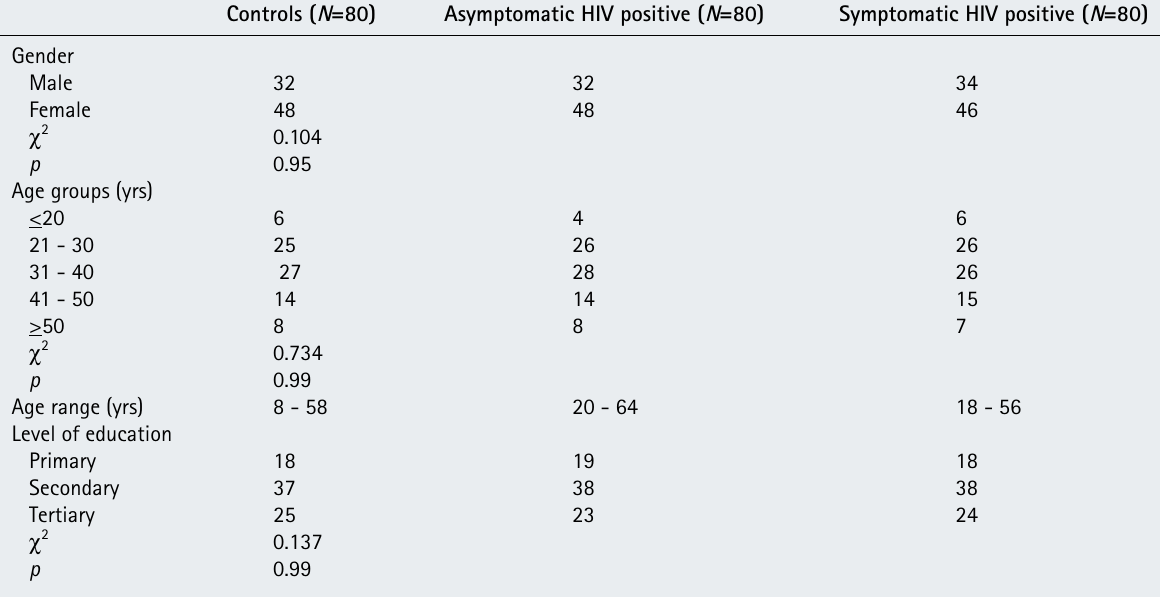
taBle i. DeMograPHic Data oF tHe StUDY SUBJectS